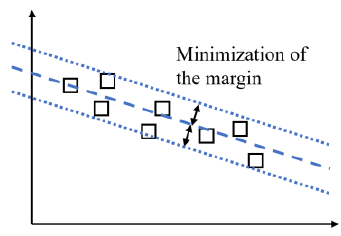
Figure 6. Support vector